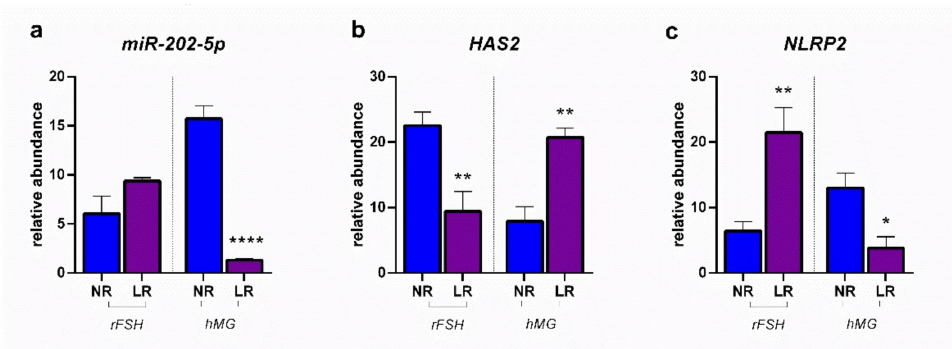
Figure 7. Expression profiles: ( a ) miR-202-5p; ( b ) HAS2 : hyaluronan synthase; ( c ) NLRP2: NLR family pyrin domain containing 2. Results are reported as mean ± standard deviation. Statistical significance was set at p < 0.05 and calculated by Student’s t-test. Asterisks above columns indicate statistical differences between NR and LR groups. * = p < 0.05; ** = p < 0.01; **** = p < 0.0001.